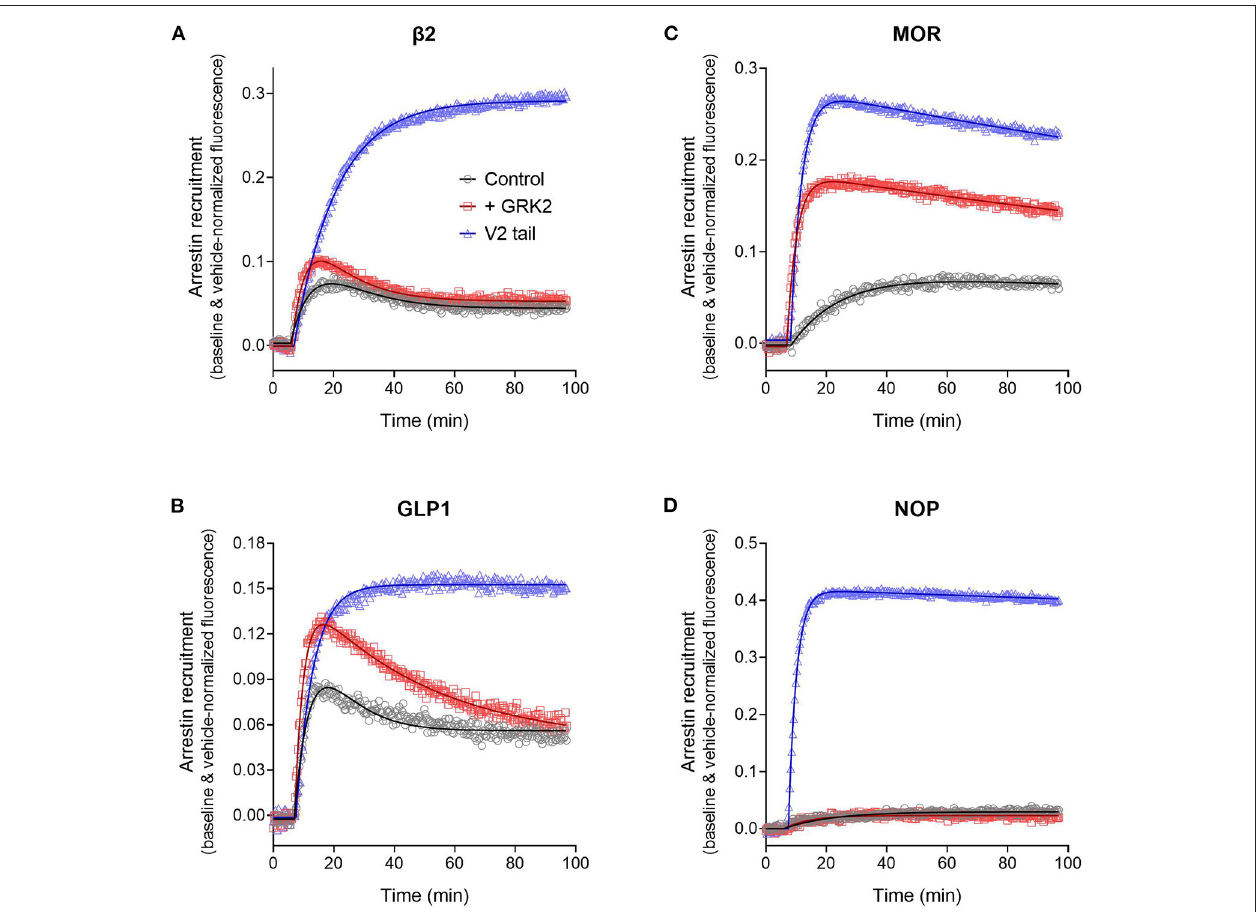
FIGURE 10 | Effect of arrestin recruitment and function modifiers on the arrestin recruitment waveform. The strength and mechanism of arrestin recruitment can be affected by the sequence of the receptor, particularly the C-terminal tail, and by expression of receptor kinase enzymes, assumed to modulate receptor phosphorylation. This was explored by grafting the V 2 vasopressin receptor C-tail onto the receptors, a determinant of high-affinity, stable arrestin interaction, and by expression of GRK2, as described in Materials and Methods. (A) β 2 adrenoceptor. (B) GLP-1 receptor. (C) µ opioid receptor. (D) NOP nociceptin receptor. Data points are the mean ± SEM of three technical replicates from a representative experiment. The curves are fits to the arrestin recruitment equations and the specific arrestin model/equation curve type is listed in Table 3